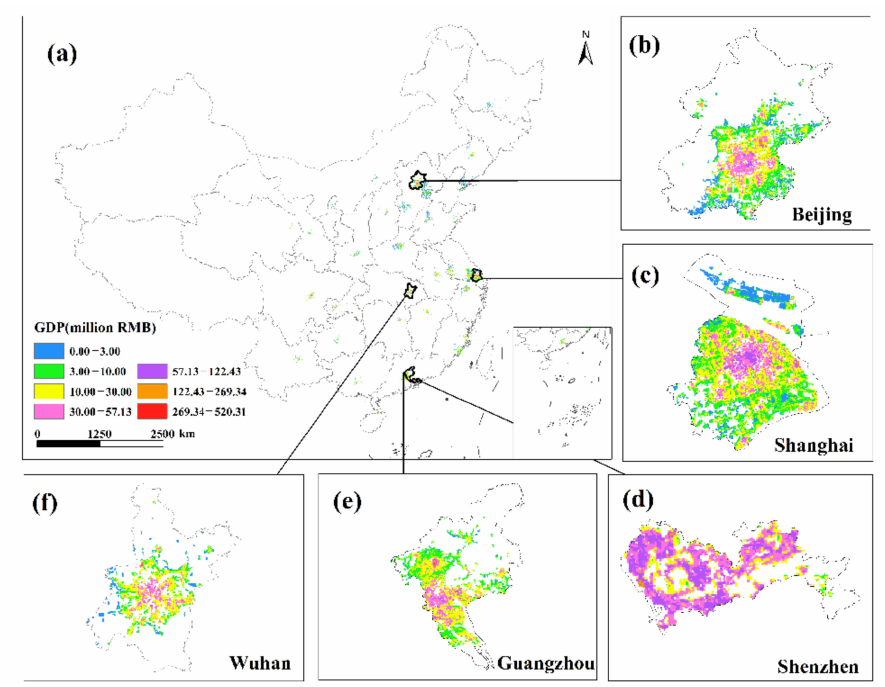
Figure 11. The spatial distribution of the total GDP of the secondary and tertiary industries in April 2020. ( a ) The spatial distribution of the total GDP in 34 Chinese cities; ( b ) Beijing; ( c ) Shanghai; ( d ) Shenzhen; ( e ) Guangzhou; ( f )